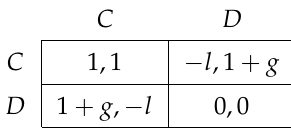
Figure 1. The payoff